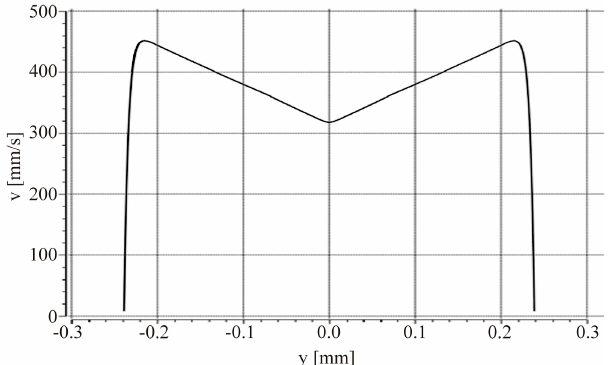
Figure 6. Parabolic flow profile in a rectangular channel having height d and width w , the dashed line shows the cross section at an arbitrary position in the channel to depict the orientation of the coordinate system (red arrows).